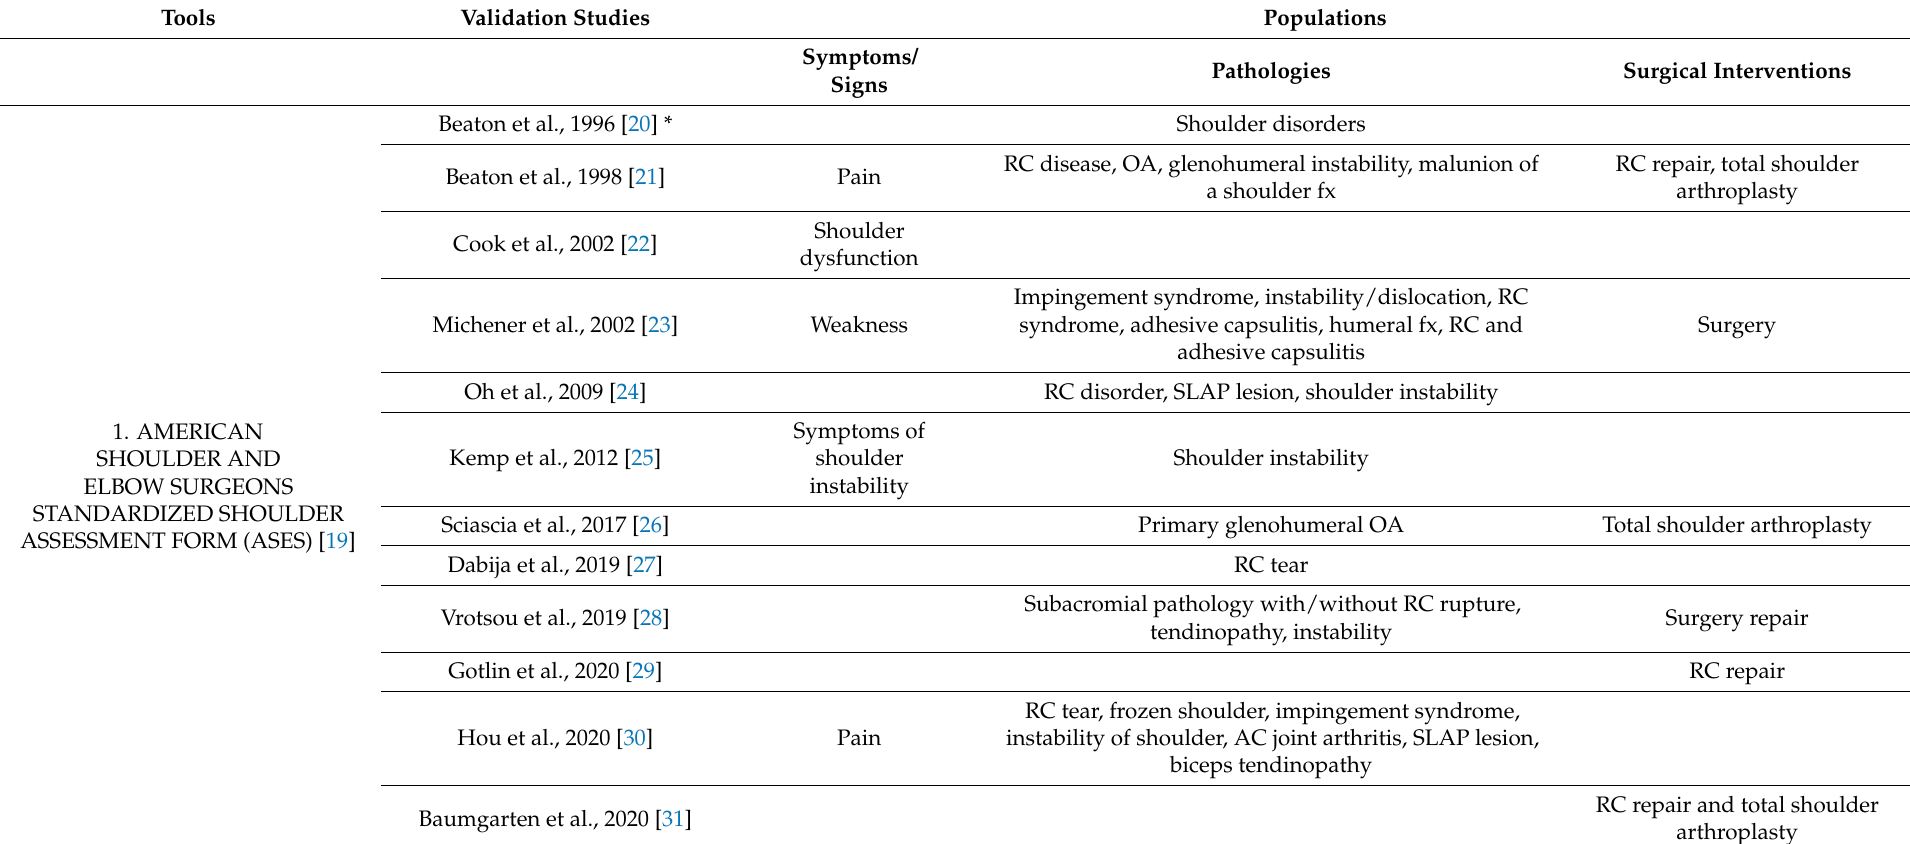
Table 5. Study population of the